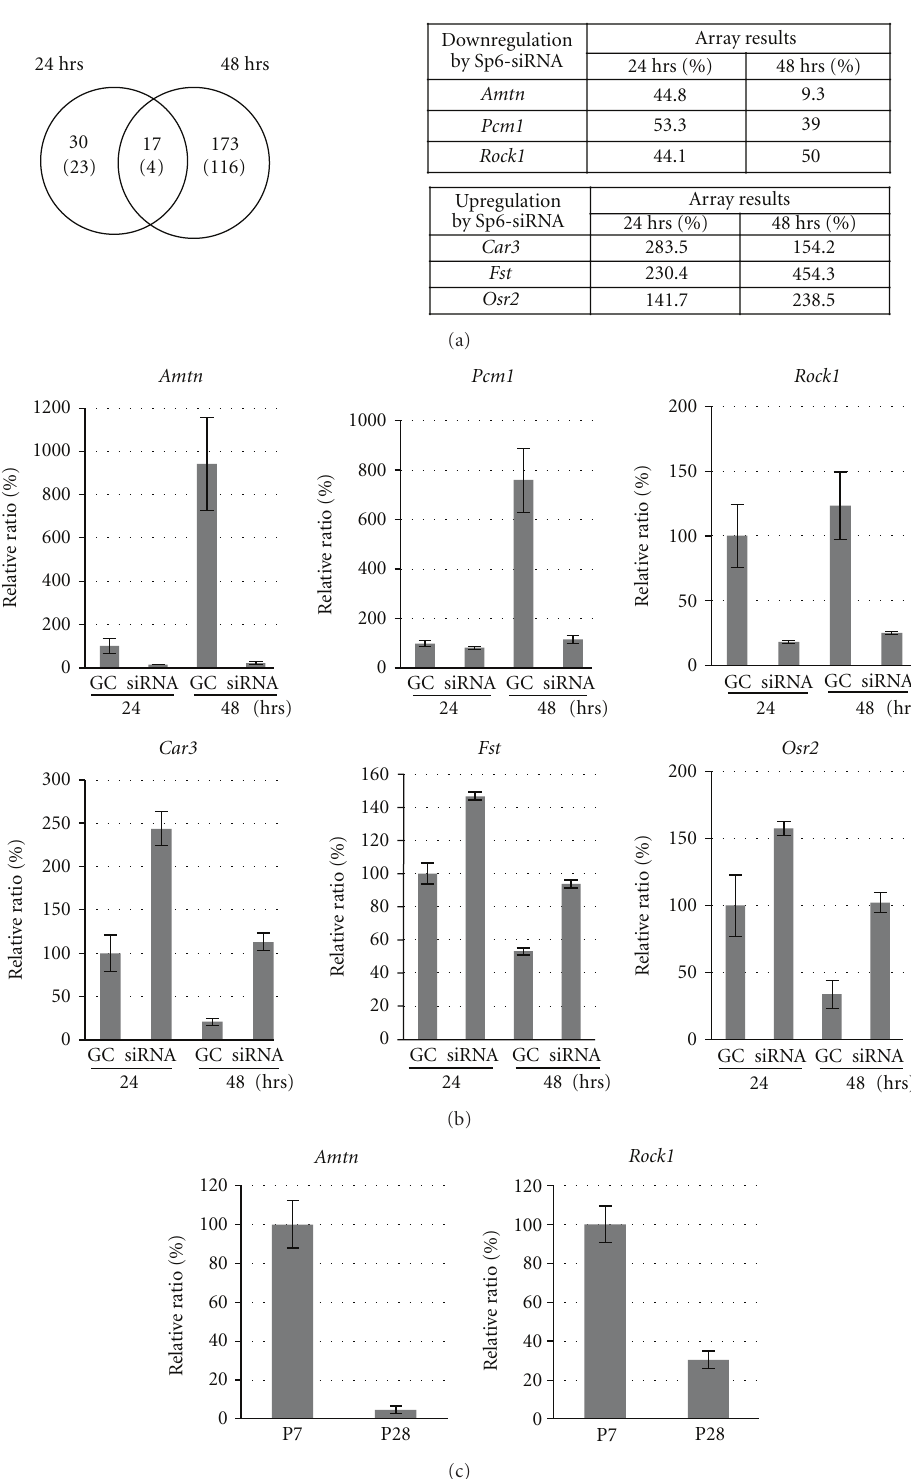
Figure 4: Screening of Sp6 target genes by microarray. (a) Venn diagram showing a summary of microarray data; the number of genes that was changed more than 2-fold between the SP6 producing sample (GC: negative control of siRNA) and the SP6 knockdown sample (siRNA of SP6) is also indicated. Numbers with brackets are unknown genes and those without brackets are known genes. The right panel indicates that the expression levels of tooth-related genes were normalized using a control (GC) based on microarray data. (b) Confirmation of microarray data by qPCR. The fold changes were calculated and compared to that of 24 h control (GC 24; 100%). GC: negative control siRNA; si: siRNA against Sp6 . All experiments were performed in triplicate. (c) The mRNA levels of the Amtn and Rock1 genes in C9 at P7 and P28. qPCR was performed with total RNA purified from C9 cells at P7 and P28 and normalized by the level of 18s rRNA . The levels of Amtn and Rock1 mRNA expression at P7 are indicated as